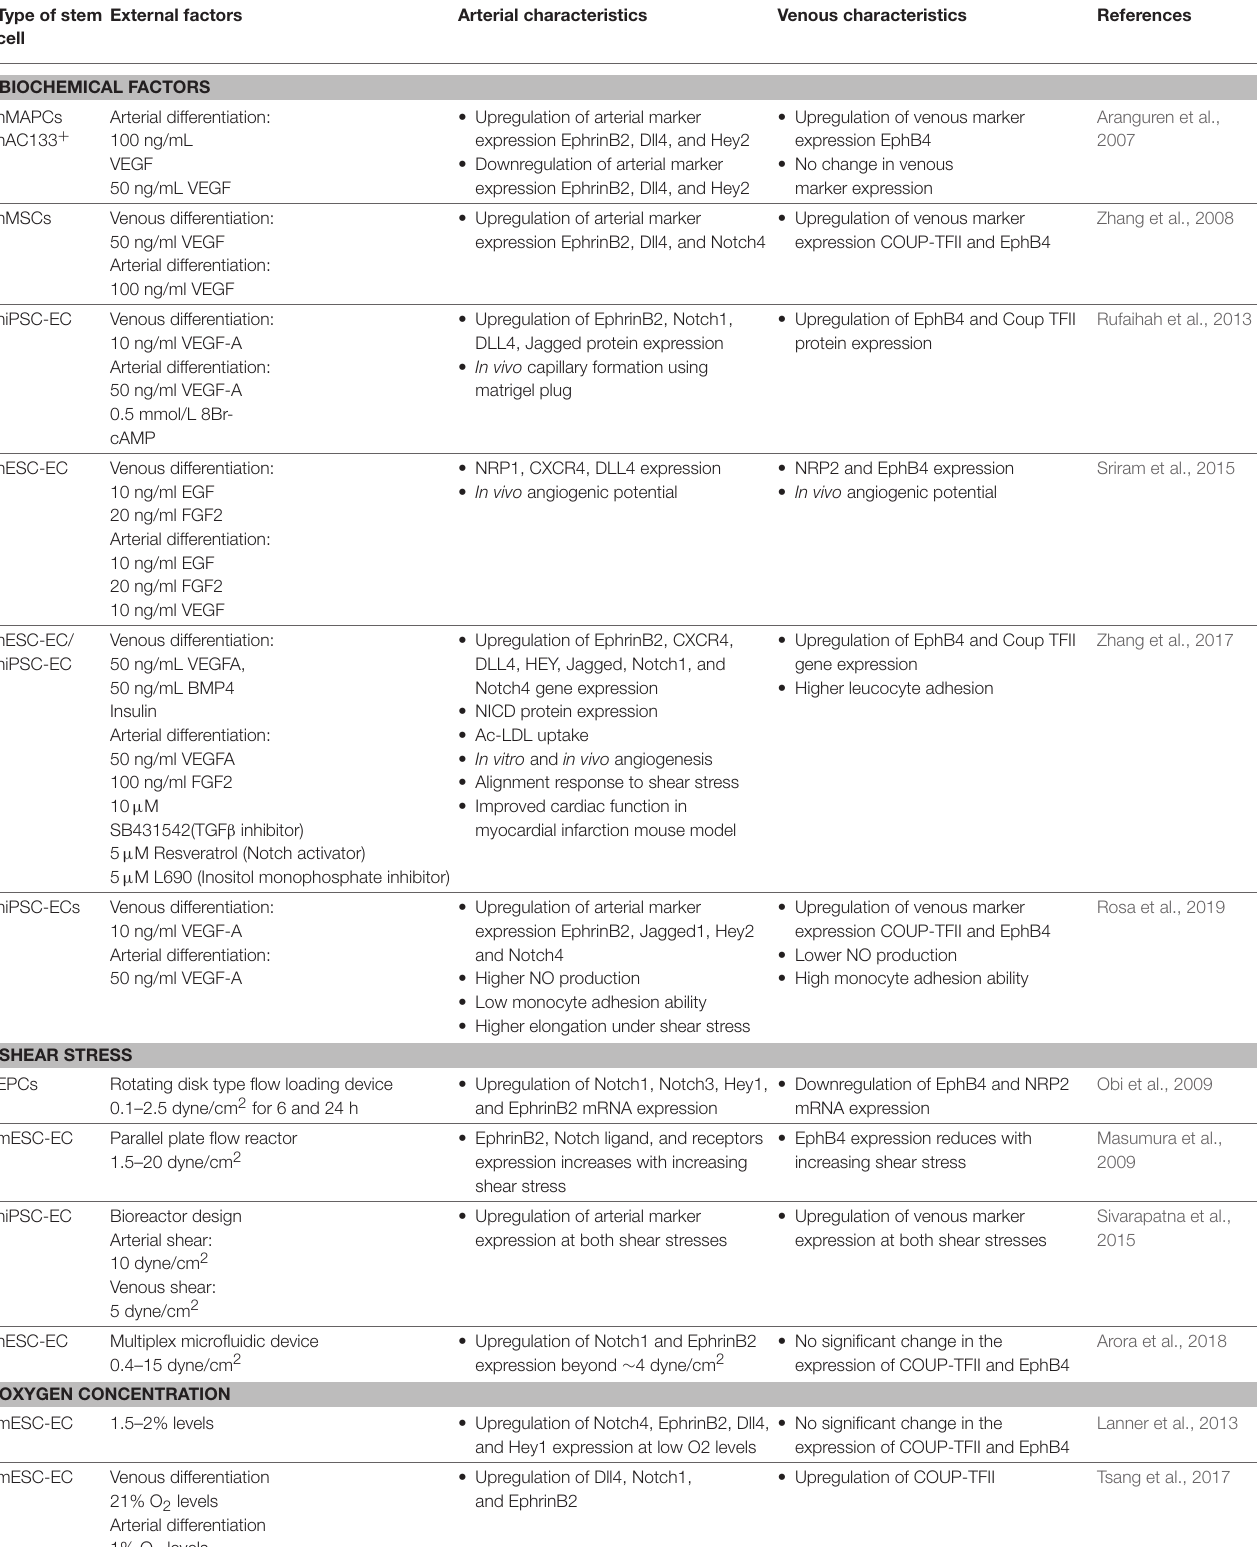
TABLE 2 | Effects of different biochemical and biophysical environmental factors on deriving arterial/venous subtypes from stem cell derived ECs. Type of stem